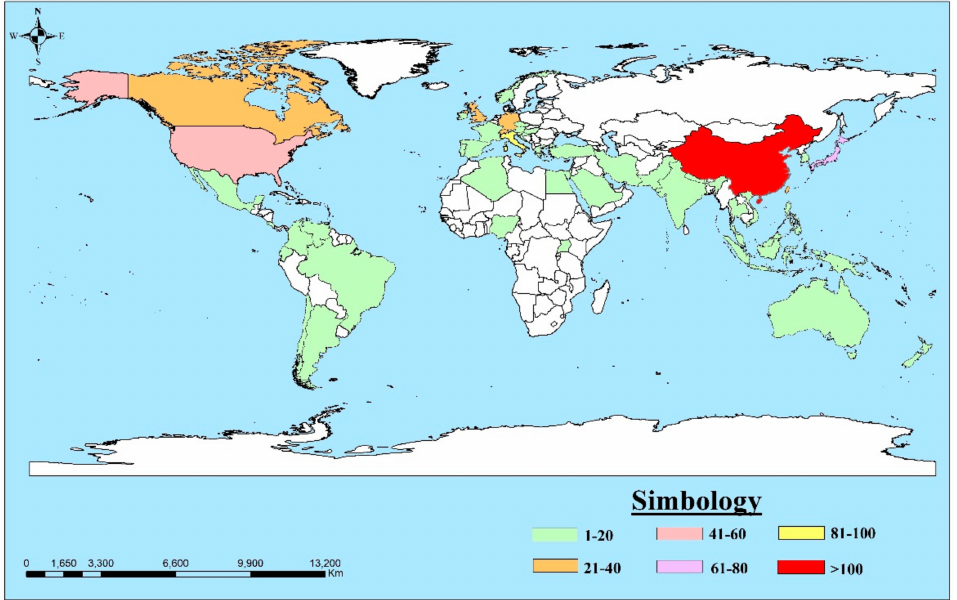
Figure 5. Contribution by countries, world